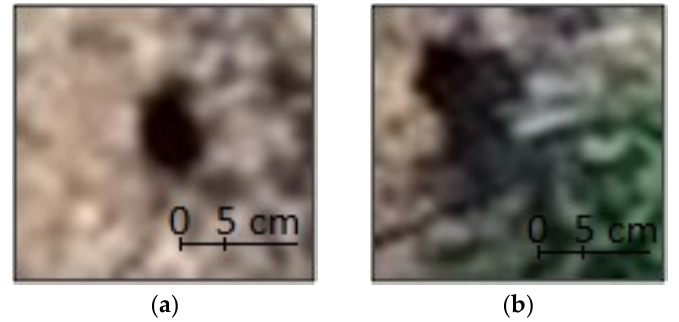
Figure 6. Examples of holes with bare soil background ( a ) and ground cover ( b ).